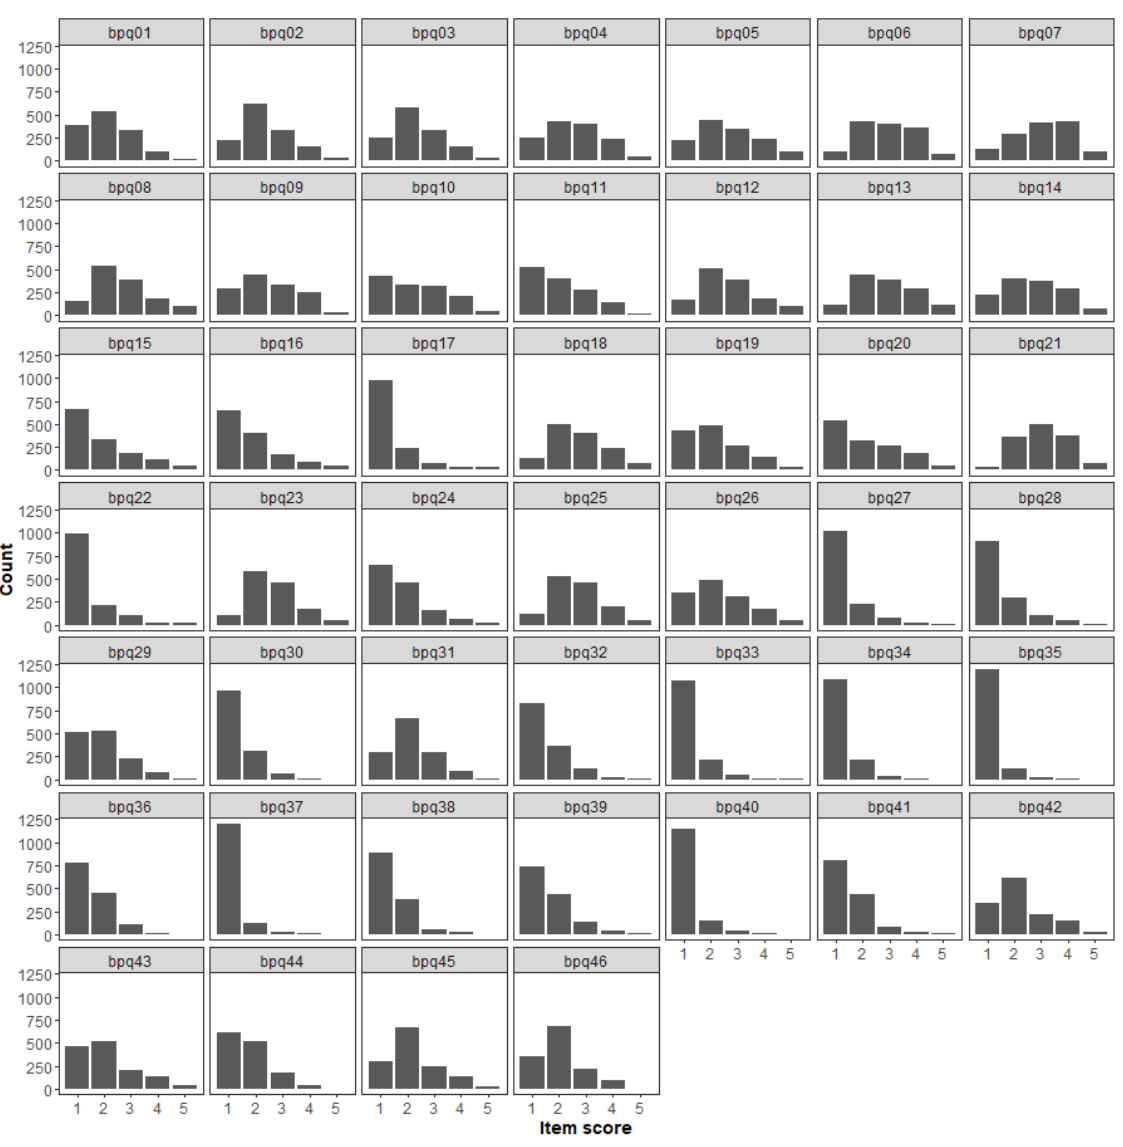
Figure 1. Item raw scores distribution in the total sample ( n = 1361).